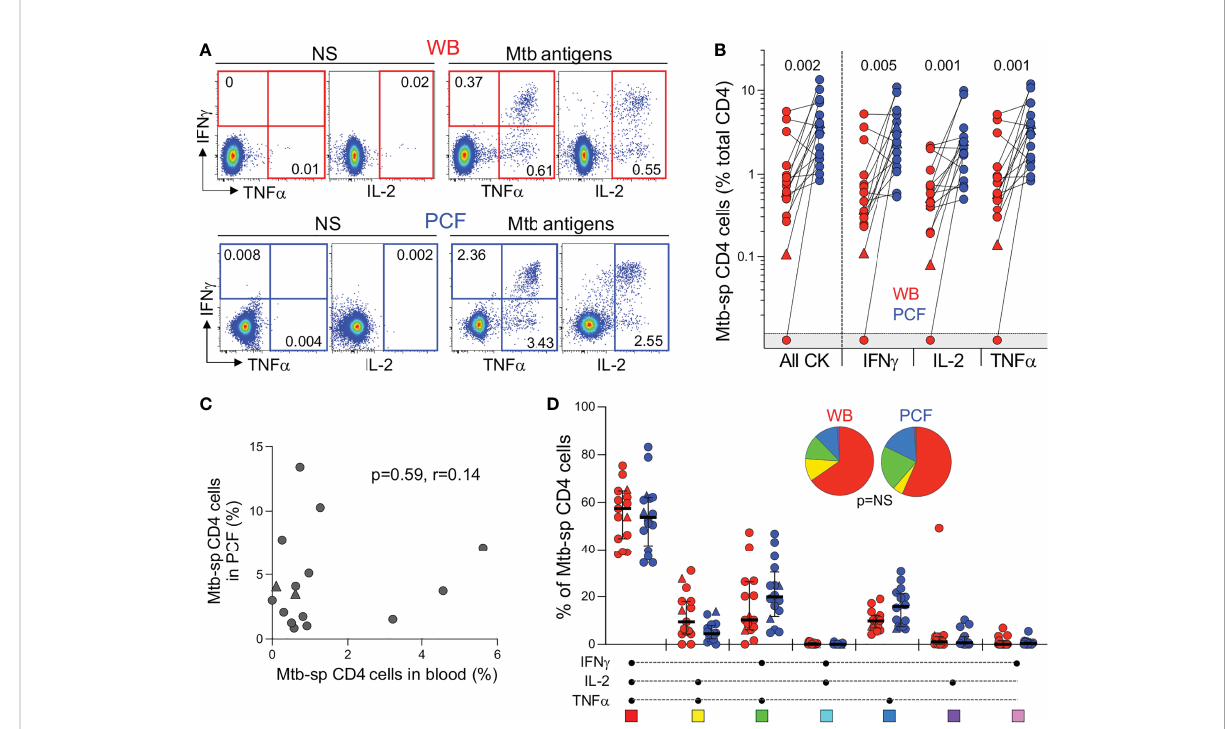
FIGURE 3 Comparison of the functional pro fi le of Mtb-speci fi c CD4 T cells between whole blood and PCF. (A) Representative example of IFN g , IL-2, and TNF a production by CD4 T cells in unstimulated (unstim) and Mtb-stimulated whole blood and PCF samples. Number represents cytokine positive cells expressed as a percentage of total CD4 T cells. (B) Magnitude of Mtb-speci fi c CD4 T cells in whole blood (red) and PCF (blue) (n = 16). The triangles depict HIV-uninfected participants (n = 2). Bars represent medians. Statistical comparisons were de fi ned using a Wilcoxon rank test. (C) Correlation between the frequency of Mtb-speci fi c CD4 T cells in blood and at site of disease (PCF). The triangles depict HIV- uninfected participants (n = 2). Correlation was tested by a two-tailed non-parametric Spearman rank test. (D) Polyfunctional pro fi le of Mtb- speci fi c CD4 T cells in whole blood (red) and PCF (blue). The x-axis displays all possible cytokine combinations ( fl avors), the composition of which is denoted with a dot for the presence of IL-2, IFN g and TNF a . The proportion of each fl avor contributing to the total Mtb-speci fi c CD4 response per individual is shown. The median (black bar) and interquartile ranges (box) are shown. Each fl avor is color ‐ coded, and data are summarized in the pie charts, representing the median contribution of each fl avor to the total Mtb response. No statistically signi fi